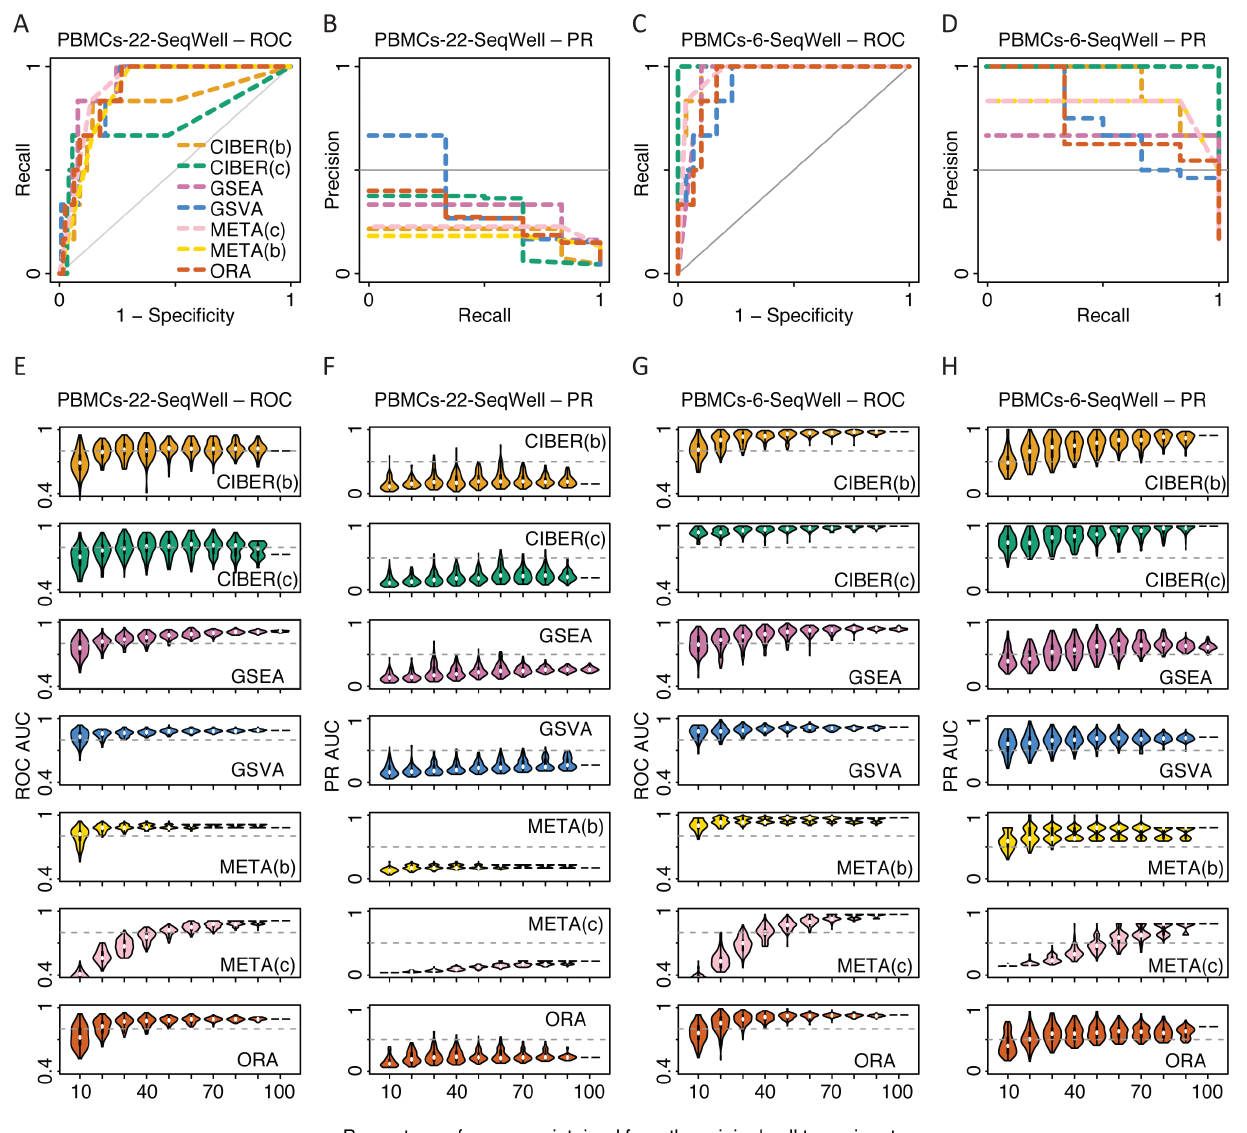
Figure 5. Performance and robustness analysis of cell type prediction methods using Seq-Well PBMCs scRNA-seq data. The same procedure as described in Figure 2 for ROC and PR AUCs of the liver and retinal neuron datasets was used here for the PBMC dataset measured with the Seq-Well technology. Please see Figure 2 legend for details. Six cell clusters from the Seq-Well scRNA-seq measurements could be mapped vs. six out of 22 cell types of the PBMC LM22 matrix signatures. This dataset was analysed in two ways. In the first way (‘PBMCs-22-SeqWell’, panels A , B , E and F ), all 22 cell type signatures from the LM22 matrix were used as input for cell type prediction methods. In the second way (‘PBMCs-6-SeqWell’, panels C , D , G and H ), only the six cell types from the LM22 that could be mapped to the six cell clusters were used as input for cell type prediction methods. For CIBERSORT and METANEIGHBOR, two approaches were used, one with the original LM22 matrix with continuous gene expression values, that we called CIBERSORT ‘continuous’ (CIBER(c)) and METANEIGHBOR ‘continuous’ (META(c)), and another with a thresholded and binarized version of the LM22 matrix, that we called CIBERSORT ‘binary’ (CIBER(b)) and METANEIGHBOR ‘binary’